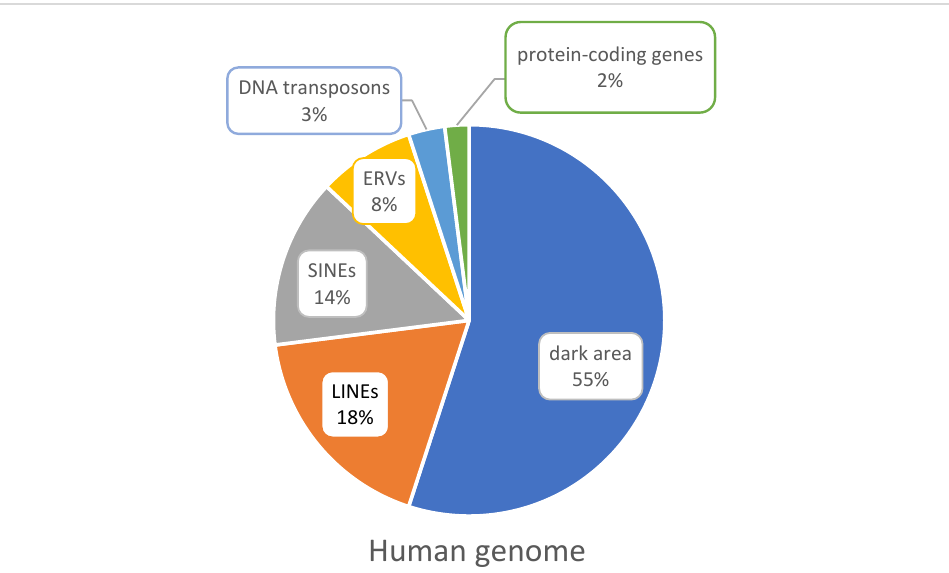
Figure 2. Relative proportions of different types of DNA sequences in the human genome. LINEs— long interspersed nuclear elements, SINEs—short interspersed nuclear elements, ERVs—endogenous